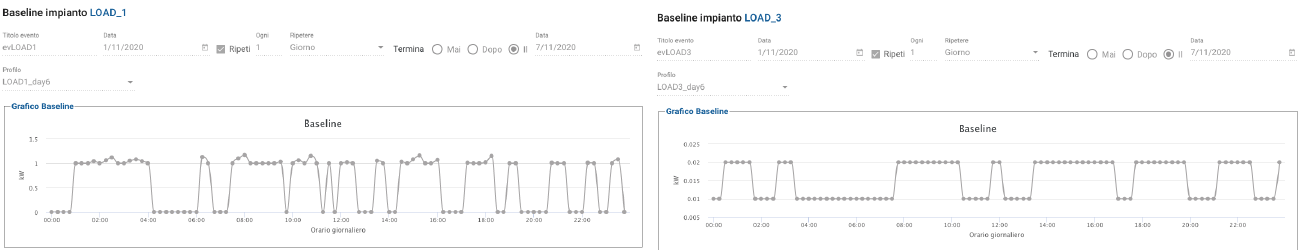
Figure 15. ( right ) Baseline for PV setting. ( left ) Baseline for WIND setting.